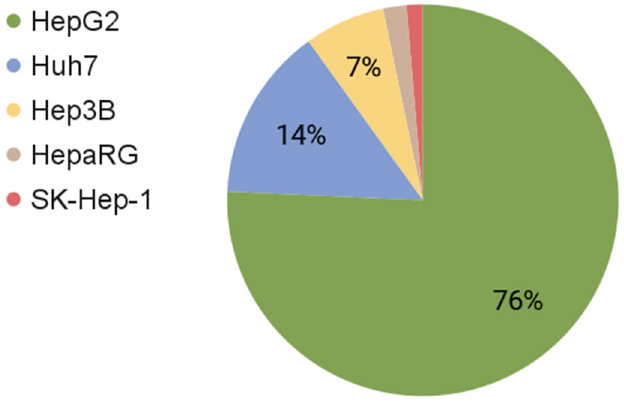
Figure 2. Percentage of manuscripts using human hepatic cell lines in accordance with the corre- sponding search term on PubMed (accessed on 23 November 2021).